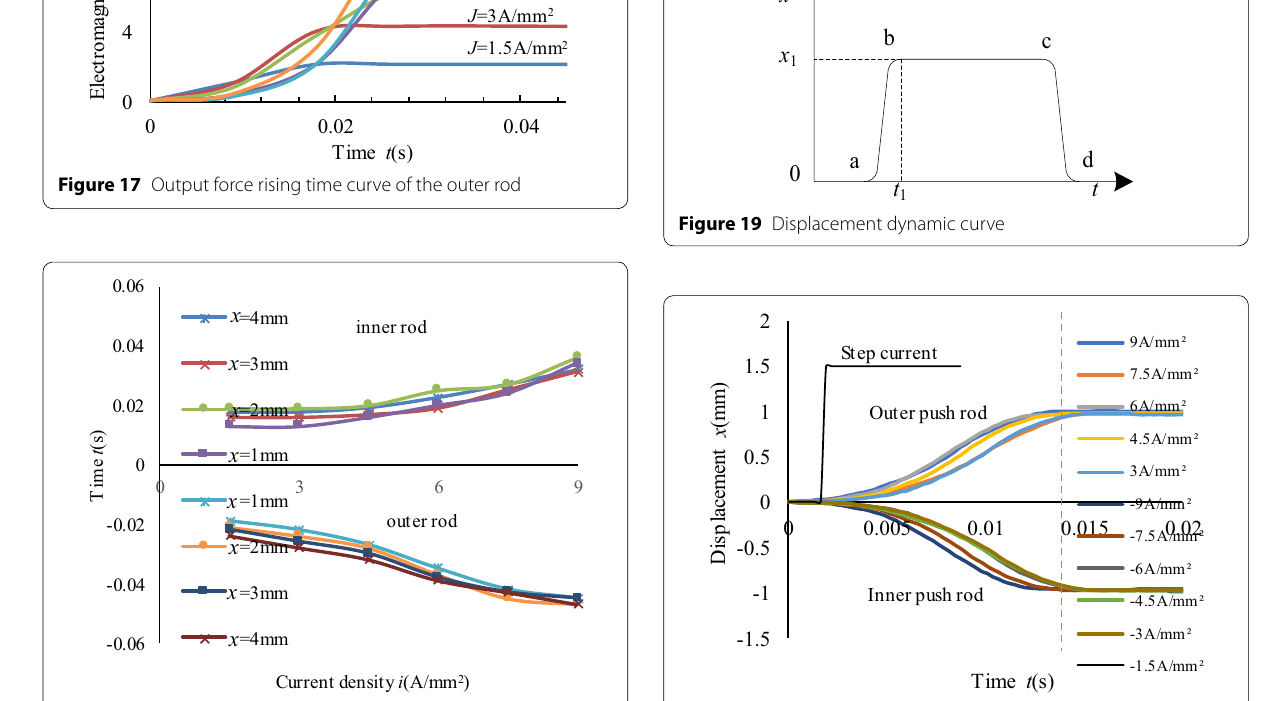
Figure 20 Displacement response curve of inner and outer